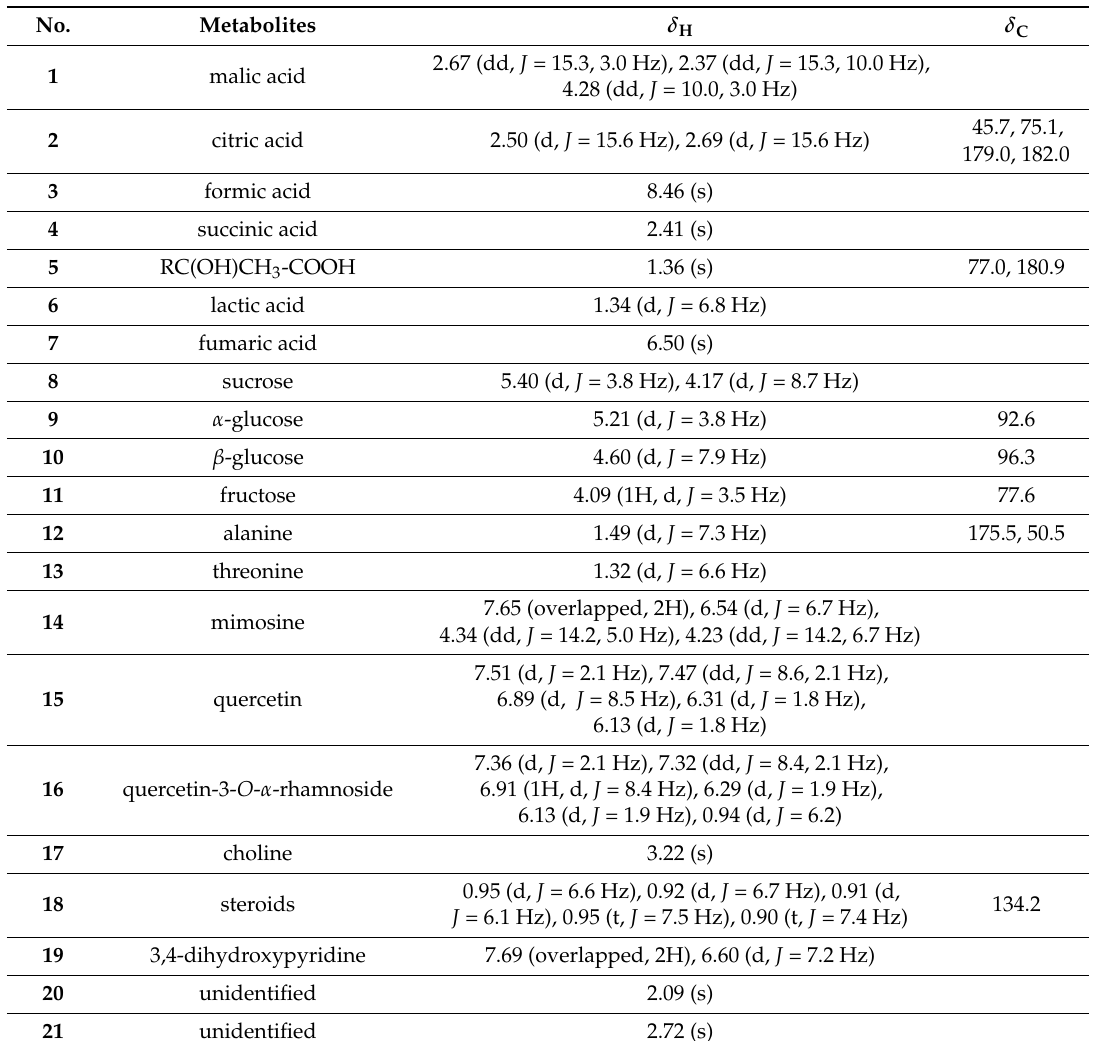
Table 1. Assignment of proton and carbon signals in the representative 1 H-NMR spectra (CD 3 OD: D 2 O =